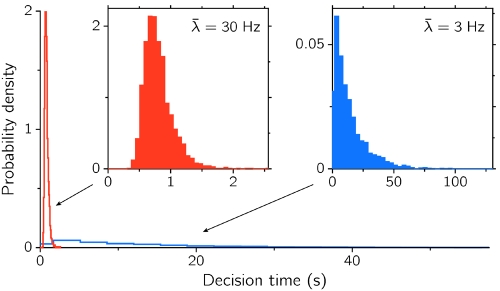
Distributions of decision times for a regime with spontaneous stable state (blue, λ̅ = 3 Hz) and without spontaneous stable state (red, λ̅ = 30 Hz), from a sample of 4000 trials each.The two insets show the distributions separately (note the different scales). N = 4500, w
+ = 1.75.